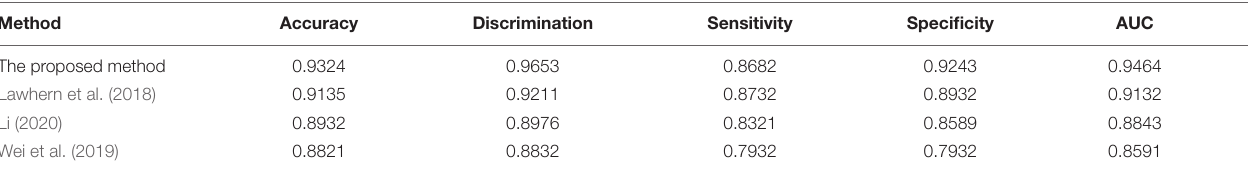
FIGURE 8 | Classification results analysis based on temporal sequence. TABLE 1 | Evaluation index of control